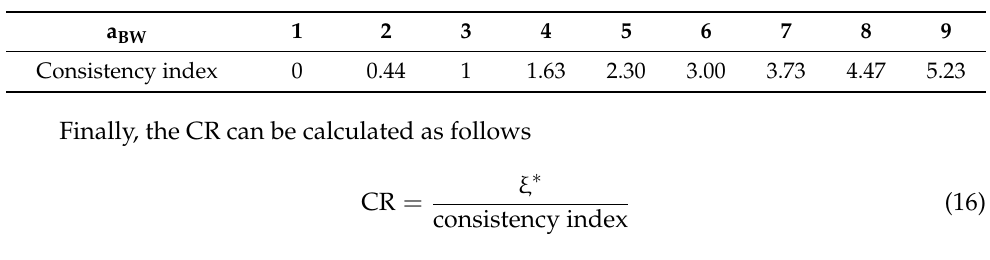
Table 1. Consistency index table.